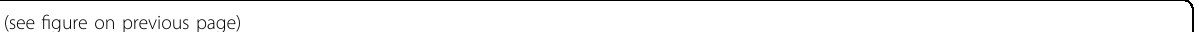
Fig. 7 Increased expression of OAS1 inhibits breast cancer cell proliferation and is involved in the oncogene function of TINCR. A qRT-PCR assays were conducted in 51 paired human breast cancer tissues and their corresponding adjacent non-tumor tissues to evaluate relative expression of OAS1, and the result was normalized against GAPDH expression. B qRT-PCR analysis of OAS1 expression in normal mammary epithelial cell line (MCF10A) and breast cancer cells. C Correlation analysis of TINCR expression (log2 value) and OAS1 mRNA level (log2 value) in 51 breast cancer tissues using Pearson ’ s correlation coef fi cient. D qRT-PCR analysis of OAS1 expression in T47D and MCF-7 cells transfected with control (empty vector), pcDNA-OAS1. E , F The viability of T47D and MCF-7 cells transfected with pcDNA-OAS1 or control (empty vector) was determined by CCK-8 and colony formation assays. Experiments were performed in triplicate. G Migration ability was investigated by transwell assays in MCF-7 cells transfected with pcDNA-OAS1 or control (empty vector). H , I CCK-8 and colony formation assays showed the cell viability of pcDNA-OAS1 and pcDNA-TINCR co-transfected T47D and MCF-7 cells. Experiments were performed in triplicate. J Migration ability was investigated by transwell assays